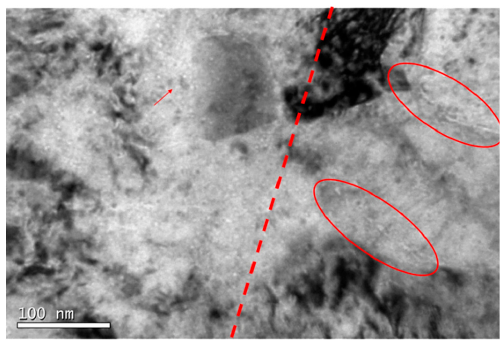
Figure 16. TEM micrograph from zone C of EU-ODS EUROFER steel annealed at 450 °C for 100 h where a possible end of a Bragg peak is indicated as well as different cavity groupings.